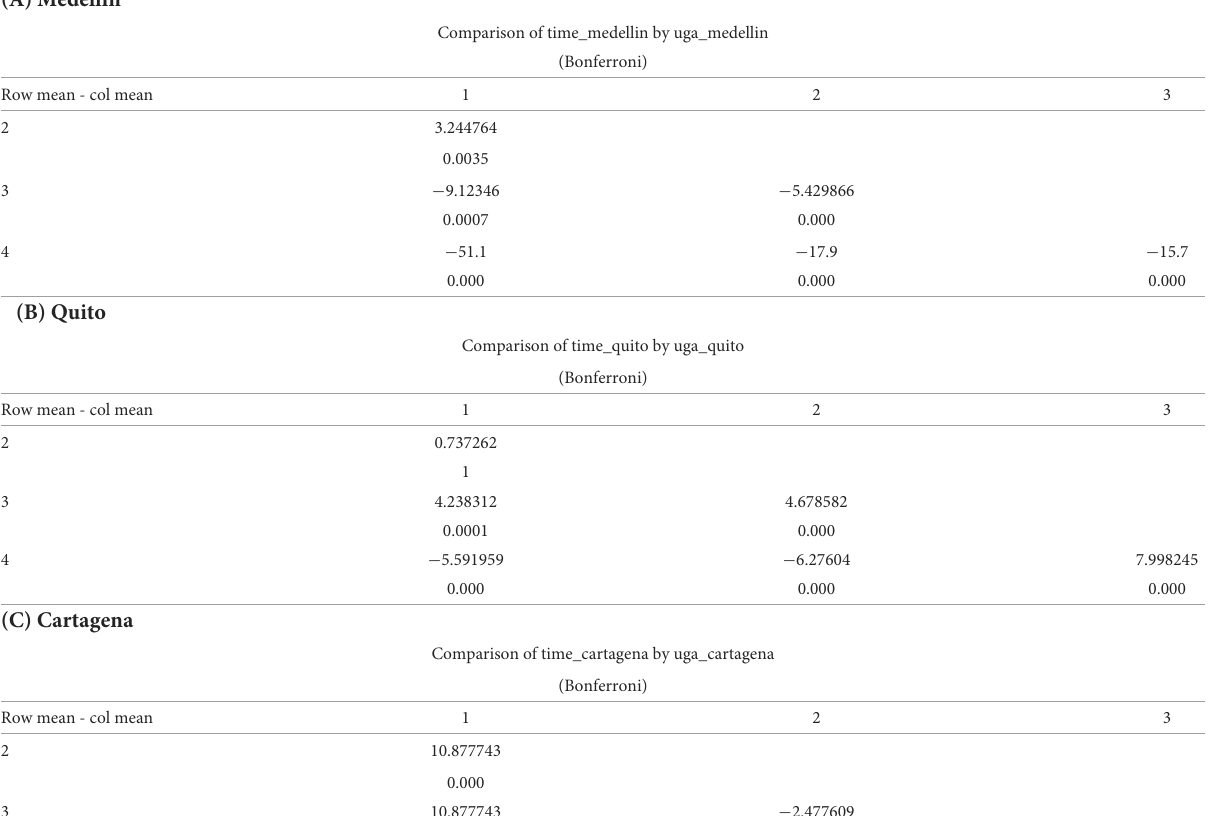
TABLE 4 Dunn’s test for each city: Medellín (A), Quito (B), Cartagena (C), and Valparaíso (D). (A)